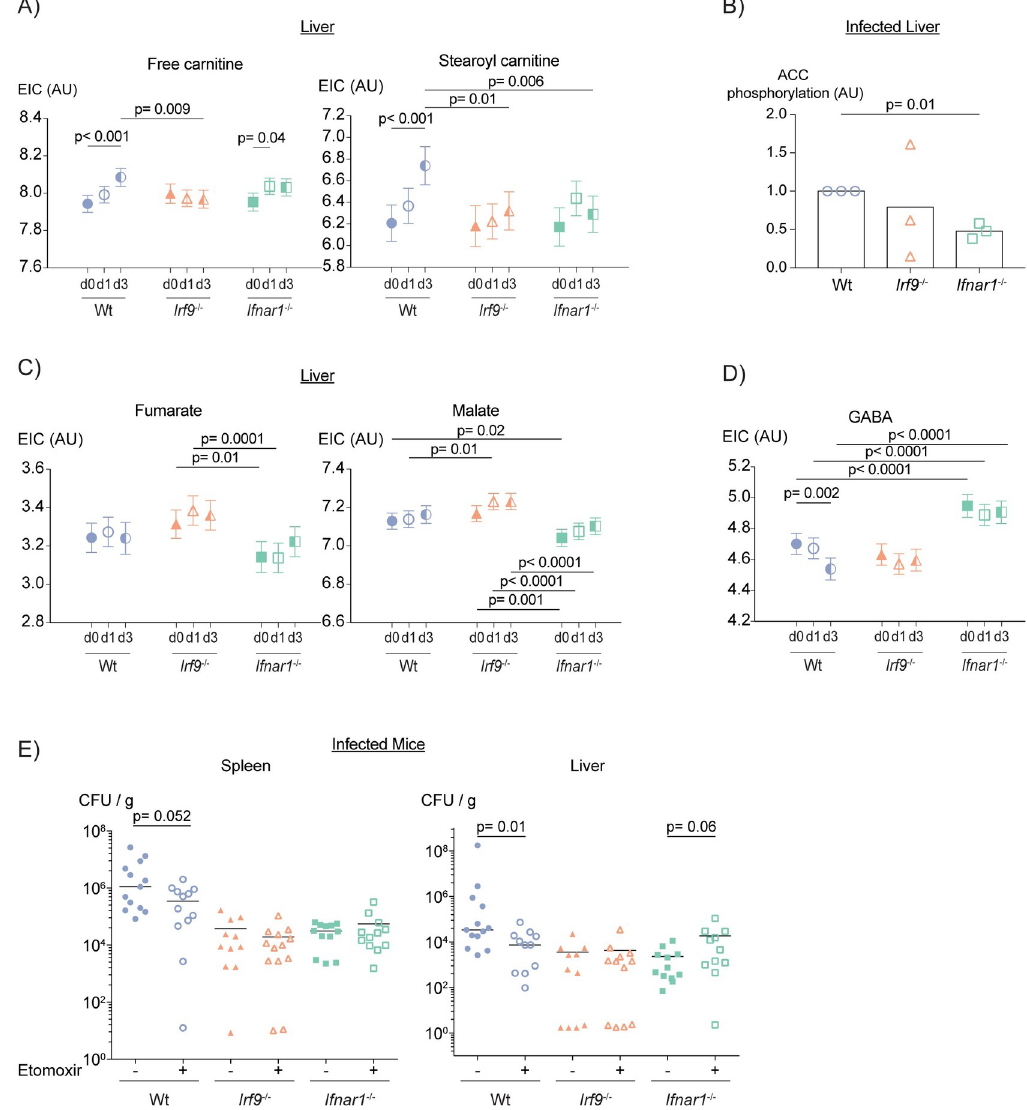
Fig 5. L . monocytogenes infection and IFN-I signaling cause changes in TCA cycle, FA and glutamine metabolism intermediates of liver. Corrected EIC (extracted ion counts) of metabolites of (A) FAO, (C) TCA cycle and (D) GABA plotted in Fig 4. The values and false discovery rate p values were calculated using values corrected for liver weight, sex of the mouse and experimental variation effects. ANCOVA test was performed. (B) Quantification of ACC phosphorylation as determined by western blot. Bars show the mean values. Each data point represents one western blot replicate of one-day infected mouse liver lysates. Error bars show minimum and maximum values. P value was calculated using ANOVA with Dunnett’s and Geisser- Greenhouse correction. (E) Bacterial loads of spleen and liver of etomoxir-treated mice three days post-infection. P values were calculated using two-tailed Mann-Whitney